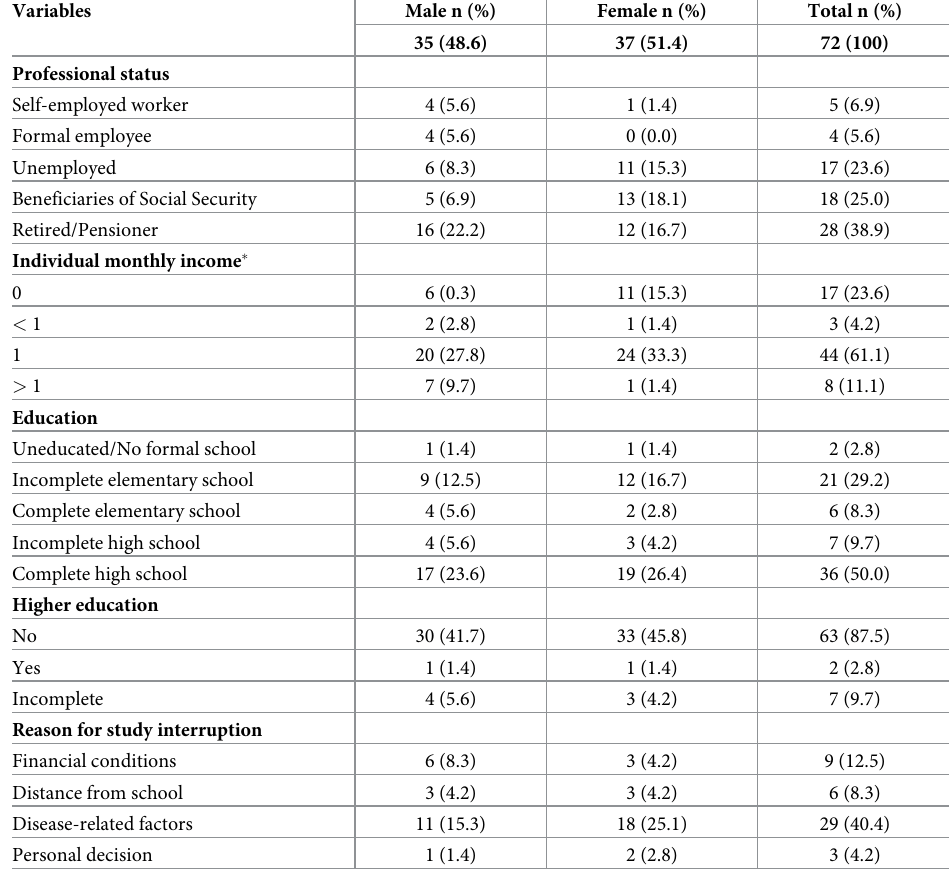
Table 2. Socioeconomic characteristics, by sex (n =